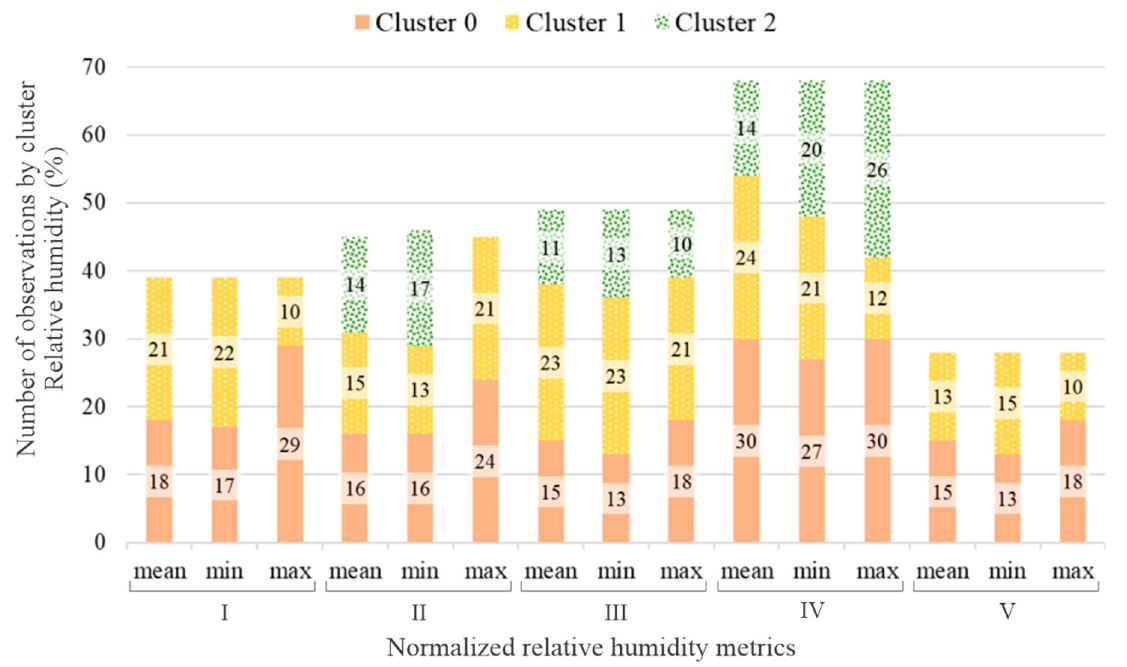
Figure 5. Stacked bars graph presenting the number of elements by cluster and relative humidity metric for each subject.